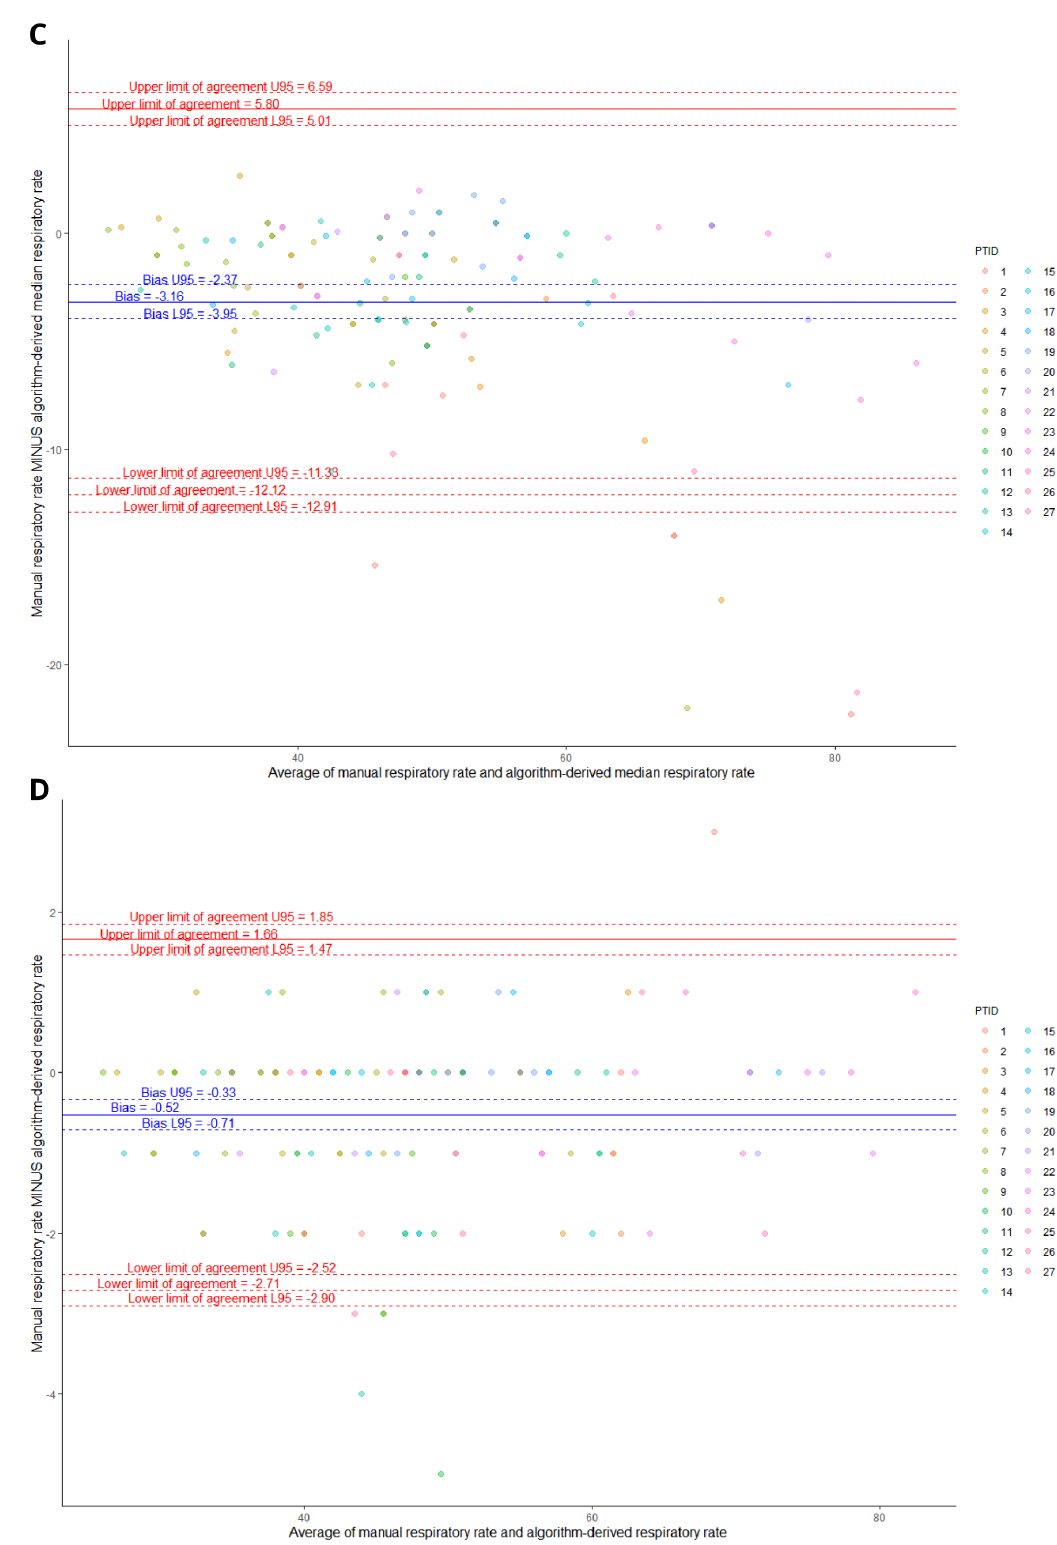
Figure 2. Bland-Altman plots comparing manual heart rate (HR) vs median pulse oximetry signal quality index (PO-SQI) HR for all epochs ( A ), modified manual HR vs median PO-SQI HR with PTID9 removed due to significant outliers ( B ), manual respiratory rate (RR) vs algorithm- derived median RR ( C ), and manual RR vs algorithm-derived RR count ( D